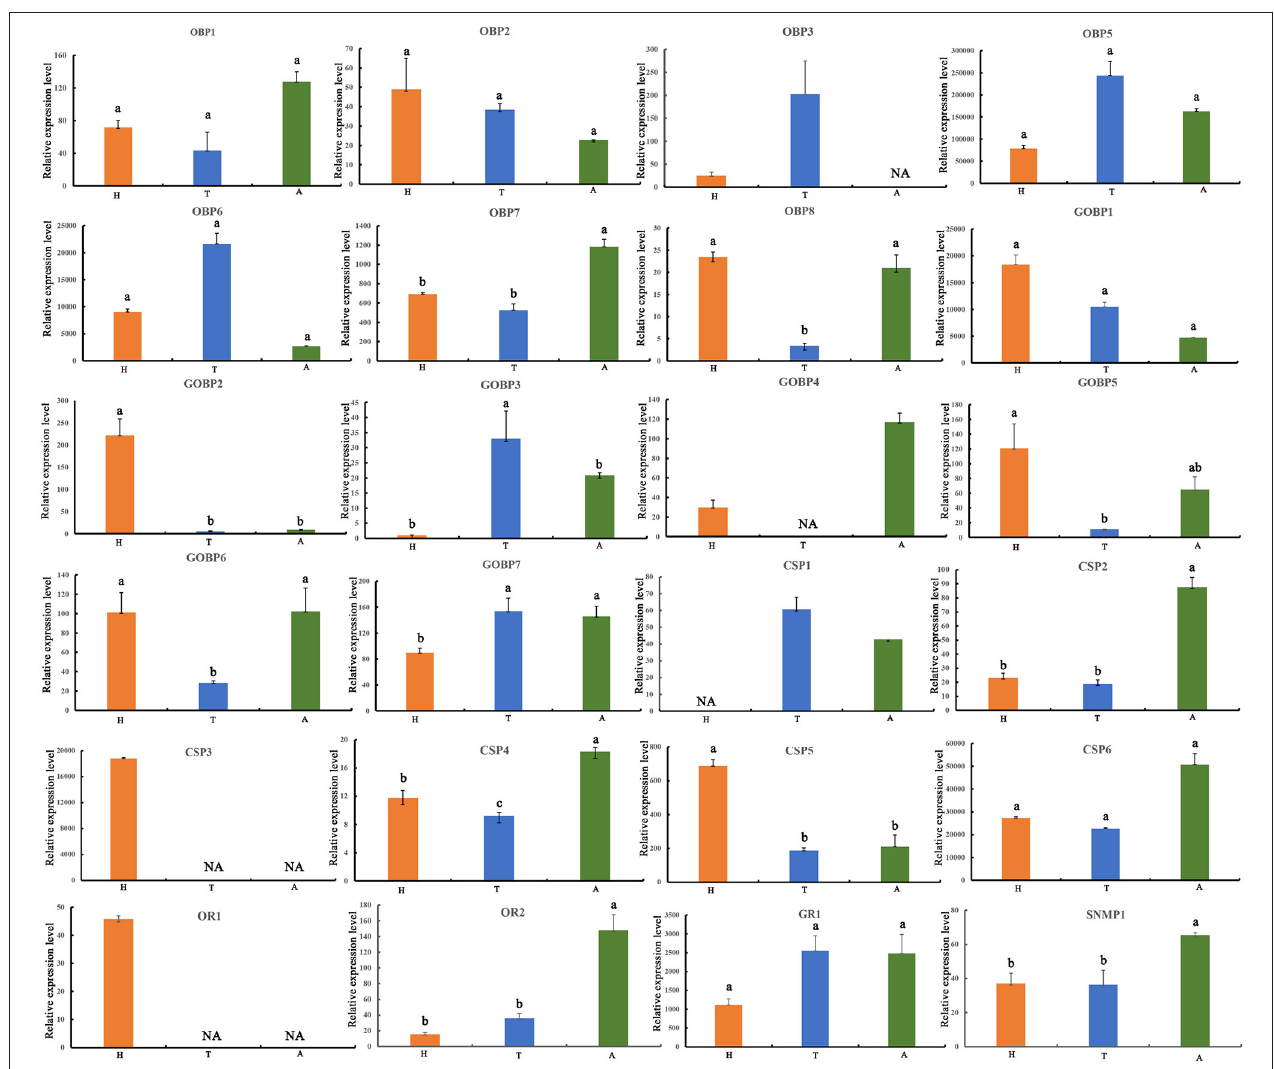
FIGURE 4 | Expression profiles of E. signifer olfactory proteins in three tissues. H, head; T, thoracic cuticle; A, abdominal cuticle, 18S was used as the reference gene to normalize target gene expression. The standard errors are represented by the error bars, different lowercase letters (a,b,c) above the bars denote significant differences at p <